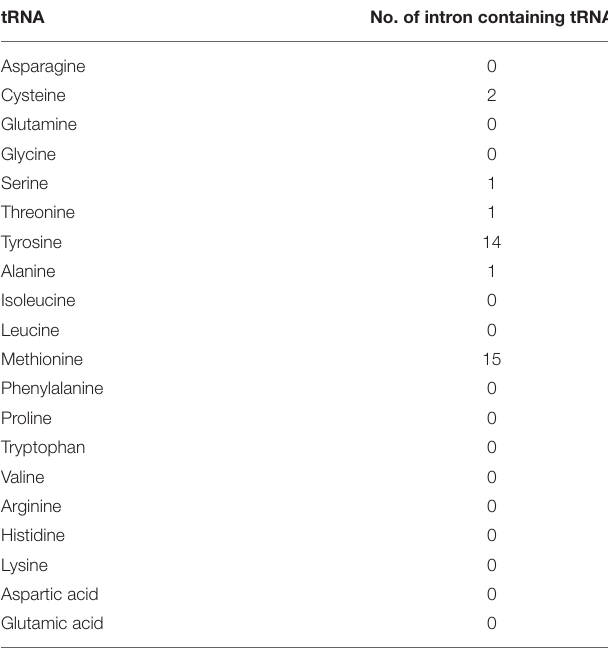
TABLE 4 | Intron containing tRNAs of O. sativa .